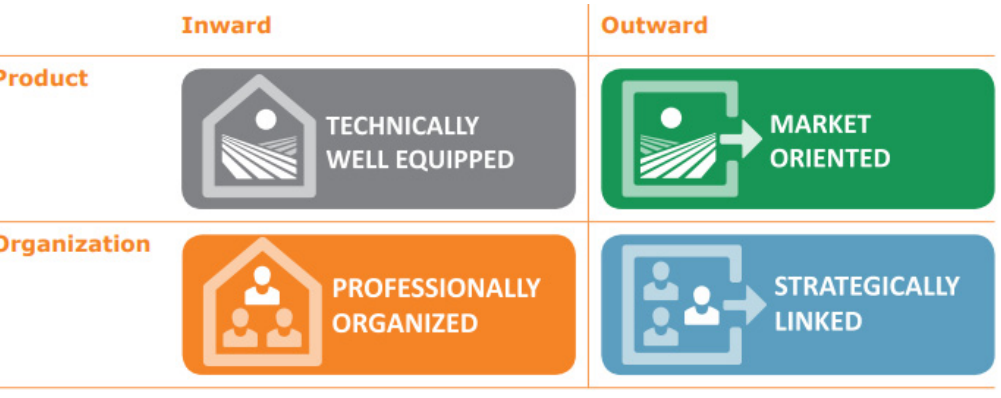
Figure 2. Building blocks used for shaping and training local seed businesses. Source: [30].